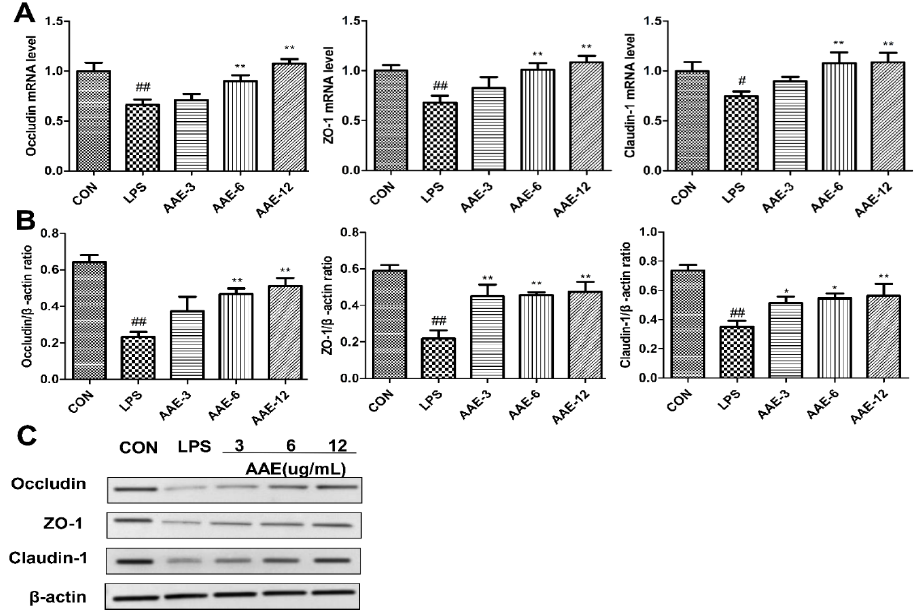
were measured by quantitative real-time PCR (qRT-PCR) ( n = 6). ( B ) Relative protein expression